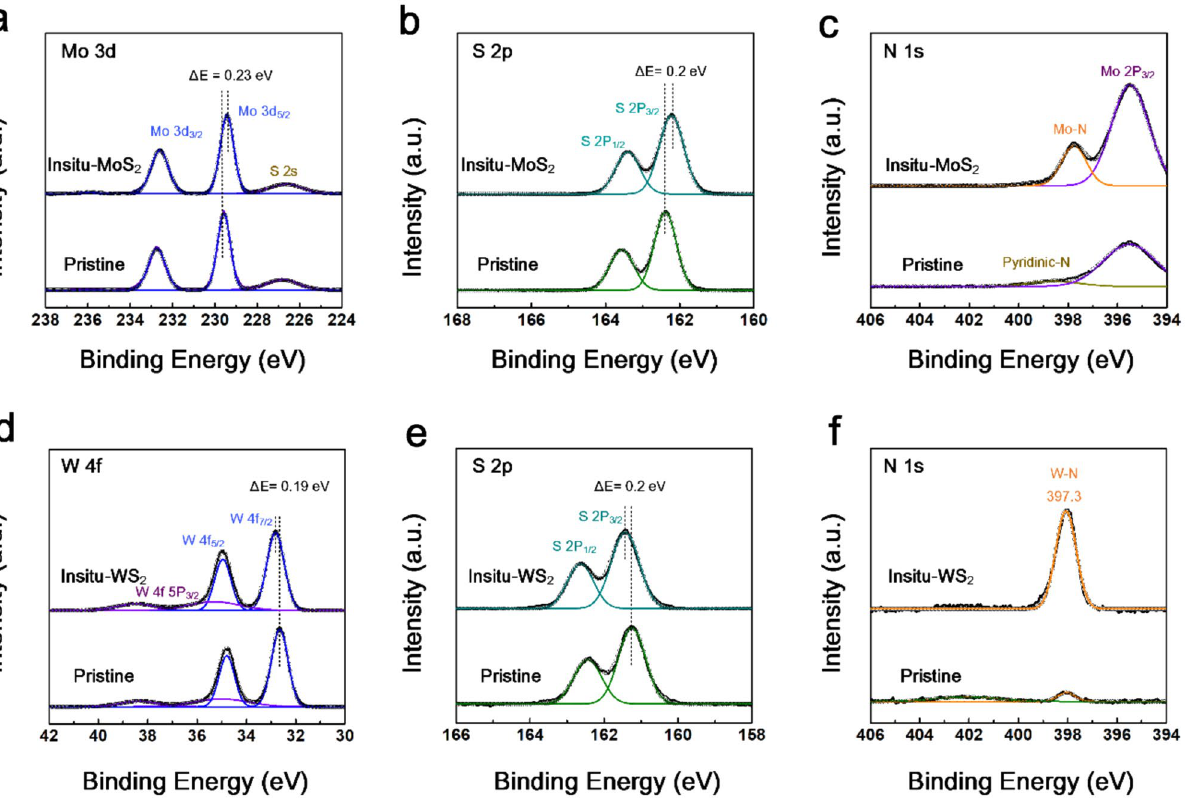
Figure 2. XPS spectra of ( a ) Mo 3d, ( b ) S 2p, and ( c ) N 1 s for pristine MoS 2 and in situ-MoS 2 . XPS spectra of ( d ) W 4f, ( e ) S 2p, and ( f ) N 1 s for pristine WS 2 and in situ-WS 2